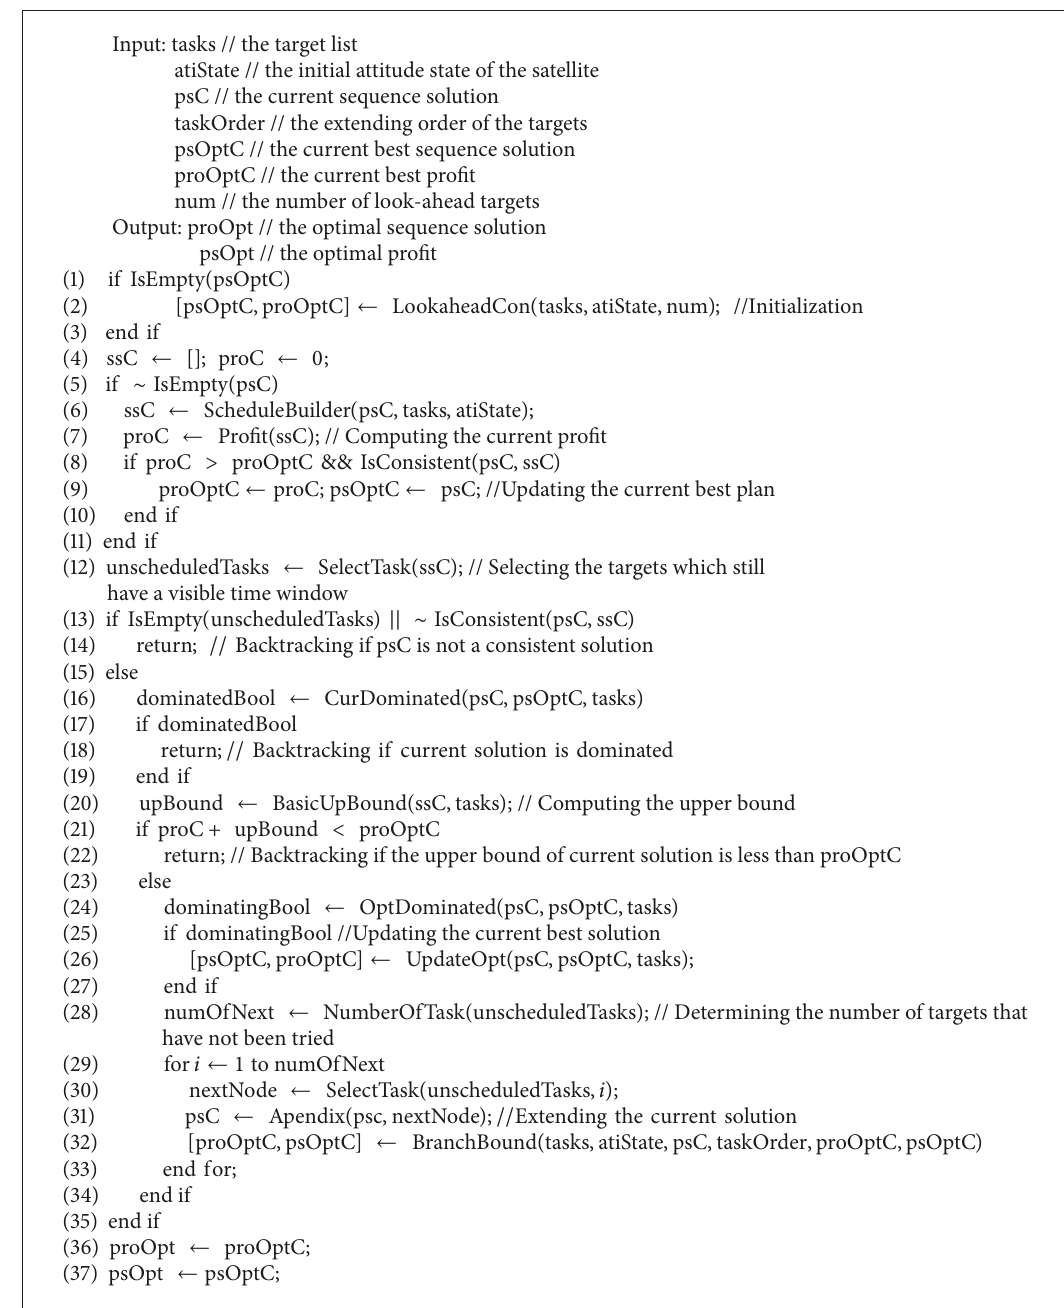
Algorithm 2: The branch and bound